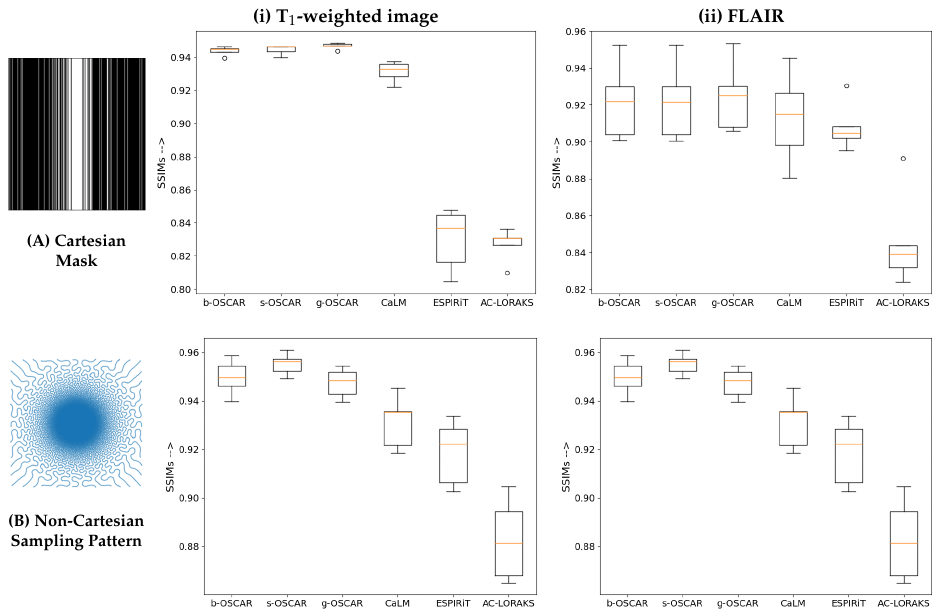
Figure 3. Retrospective results for Cartesian mask (A) and non-Cartesian undersampling pattern (B) on T1 weighted (i) and FLAIR (ii) images of the brain fastMRI data set. The results are presented in the form of box plots, computed over S = 5 slices. From left to right in each boxplot, we compared subbandwise OSCAR (b-OSCAR), scalewise OSCAR (s-OSCAR), global OSCAR (g-OSCAR), CaLM, L1-ESPiRIT and AC-LORAKS, reconstruction methods.